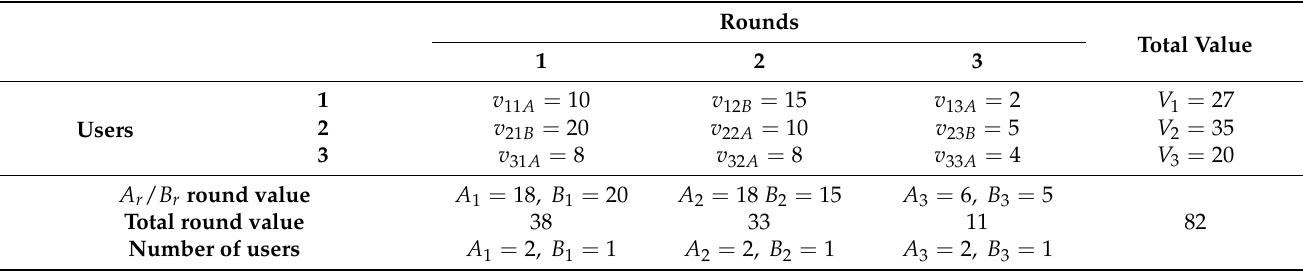
Table 1. Users’ values with three voting